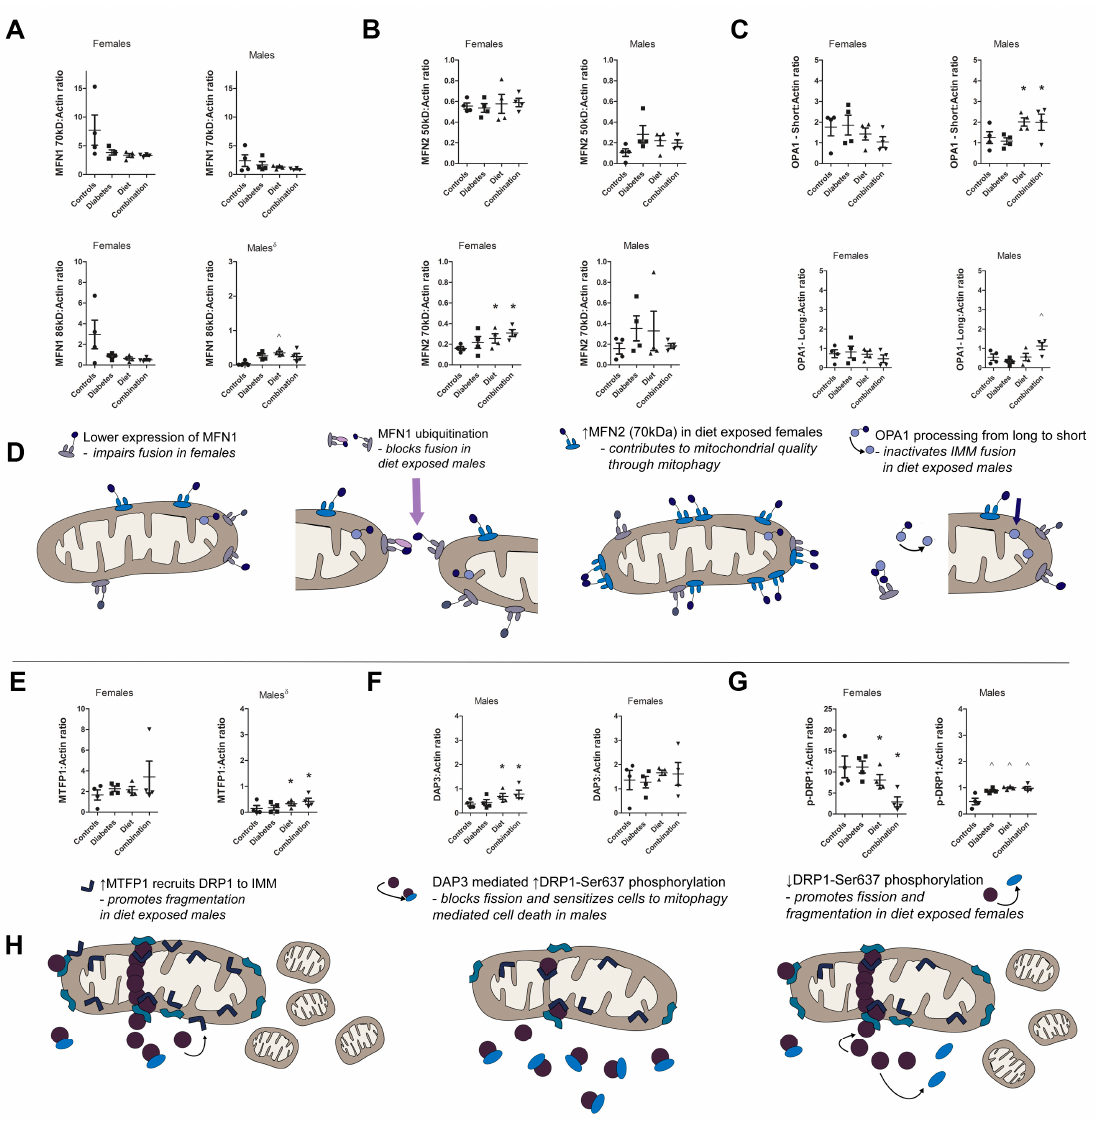
Figure 6. Post-translational modifications of dynamism regulatory proteins may explain altered dynamism in diabetes- and high-fat diet-exposed offspring hearts. Whole heart protein lysate from control, diabetes, high-fat diet, and combination exposed newborn rats was analyzed for known post-translational modifications known to affect ( A – D ) fusion and ( E – G ) fission. ( A ) MFN1 blots had two bands, the primary 70 kDa (active) band and an 86 kDa (inactive) diubiquitinated band (16 kDa higher) [35]. Diabetes- and diet-exposed females had a trend towards lower expression of both bands. Diet-exposed males had lower 70 kDa alongside higher 86 kDa MFN1, that is consistent with diet-related inactivation. ( B ) MFN2 blots had bands at 50 kDa (mitochondrial-endoplasmic/sarcoplasmic reticulum (ER/SR) junction) and 70 kDa (OMM) [55]. Diet-exposed offspring had higher expression of 70 kDa MFN2. There was no difference in expression of the 50 kDa band. ( C ) OPA1 had two long (pro-survival) bands and three short (anti-survival) bands. Long and short bands were averaged for group comparisons. Diet-exposed males, but not females, had higher expression of short (pro-fission) OPA1. ( D ) Proposed mechanisms of impaired fusion are expressed in graphical form. ( E ) MTFP1 pro-fission and pro-mitophagy protein was more abundant in female than male hearts in every group. Diet exposure increased expression of MTFP1 in males. ( F ) Diet-exposed male, but not female hearts had higher DAP3 expression than controls. DAP3 inactivates DRP1 through Ser 637 phosphorylation. ( G ) Downstream DRP1-Ser 637 phosphorylation was higher in diabetes- and diet-exposed male hearts. However, diet-exposed female hearts had decreased phosphorylation that could promote fission and